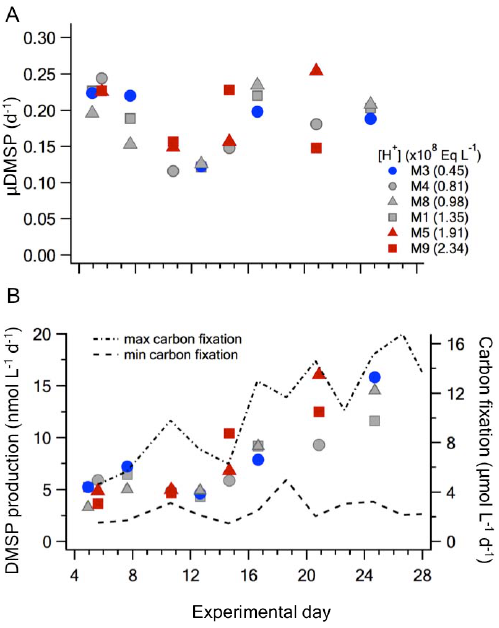
Fig. 4. Synthesis and production of DMSP in six mesocosms dur- ing the experiment: (A) specific synthesis rate (µDMSP); and (B) production of DMSPt measured over approximately 24h. The av- erage [H + ] for each mesocosm is shown in the legend. The pattern of carbon fixation based on 14 C-incorporation over 24h is shown as minimum and maximum values on each day amongst the nine